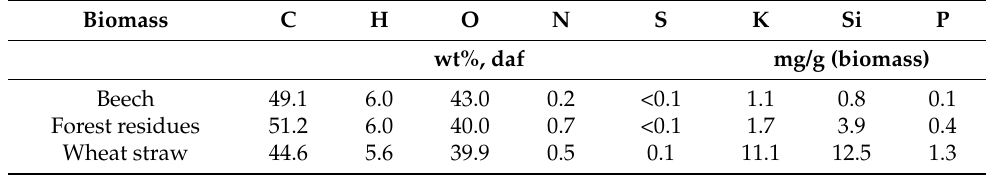
Table 2. Biomass main elemental